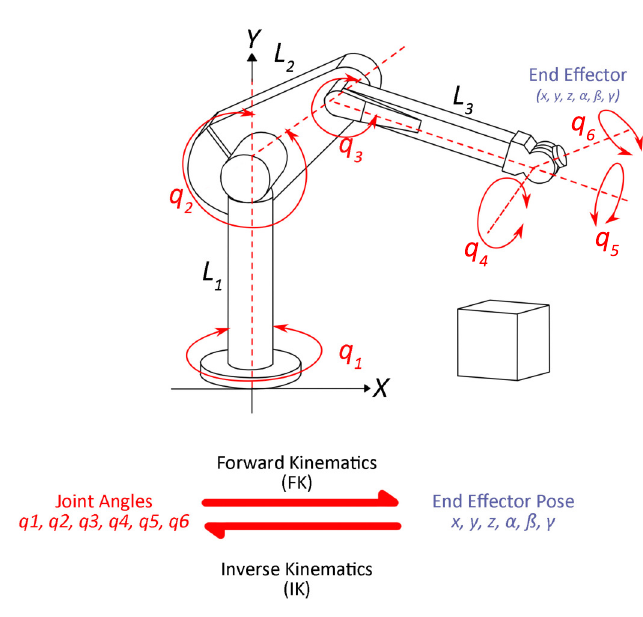
Figure 2. Manipulator robot, with relationship between forward and inverse